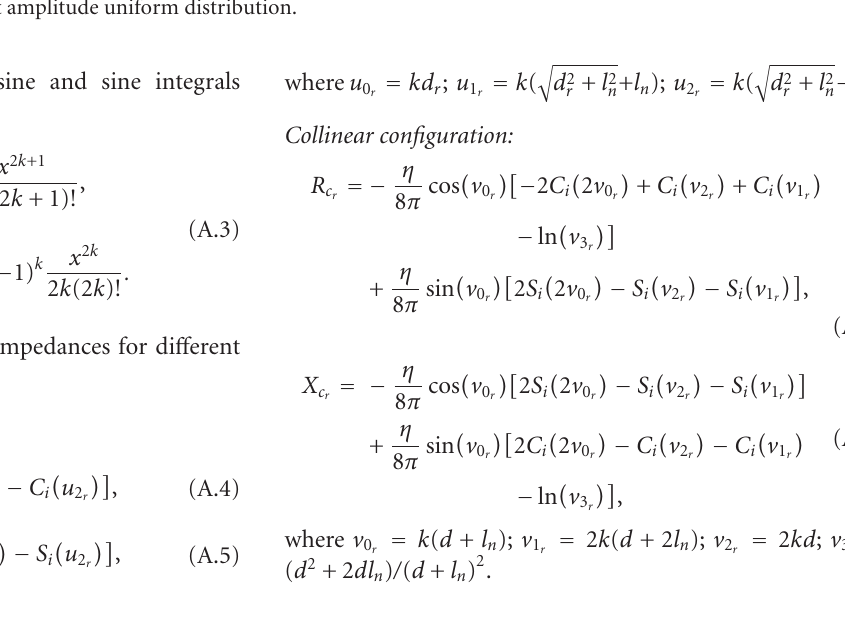
Figure 19: E ff ect of mutual coupling on RCS of series-fed linear parallel-in-echelon dipole array of N = 30, ψ = π/ 2, d = 0 . 1 λ , l = 0 . 5 λ , a = 10 − 5 λ , Z 0 = 125 Ω , and Z l = 235 Ω ; unit amplitude uniform